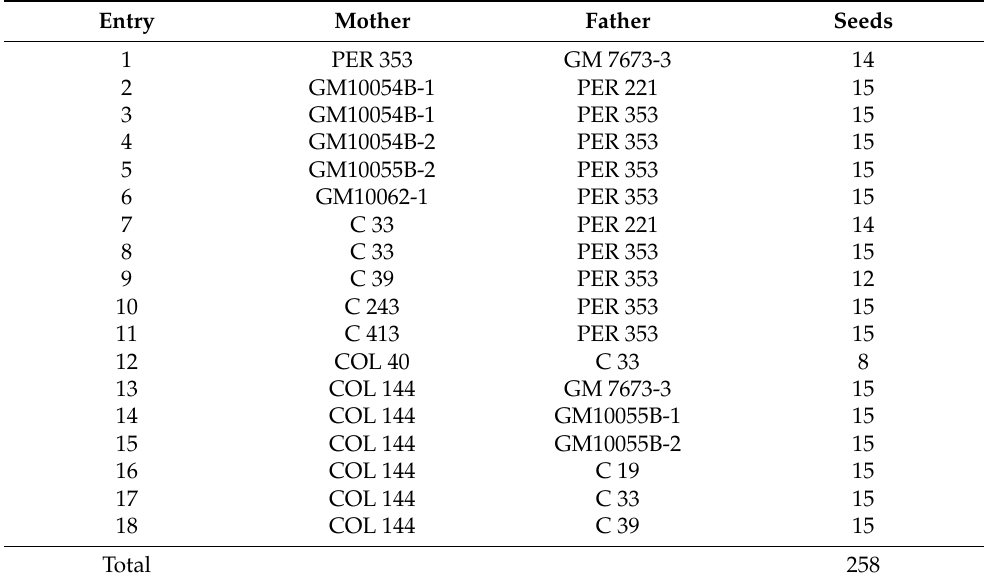
Table 2. Seeds from families (Entry) obtained from crossing cassava lines with known U/CBSV resistance status.